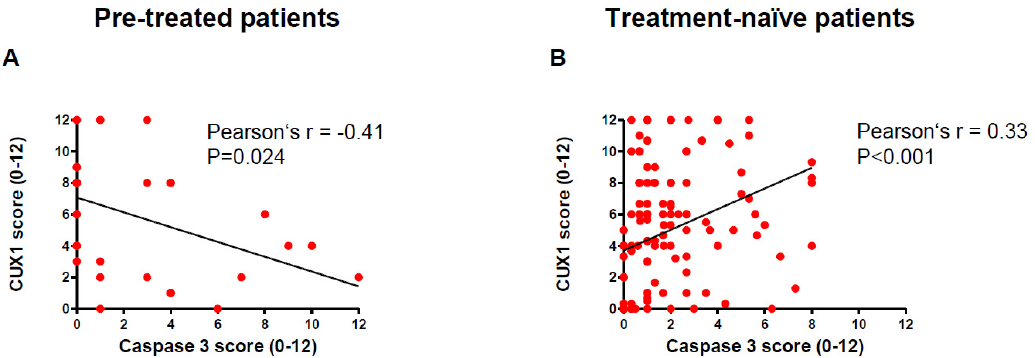
Figure 4. ( A )Pearson’s correlation test between CUX1 und caspase 3 IRS in the pre-treated group. Number of pairs = 31, 95% CI -0.66 to -0.059, r = − 0.41, p = 0.024. ( B ) Pearson’s correlation test between CUX1 und caspase 3 IRS in the treatment-naïve group. Number of pairs = 141, 95% CI 0.17 to 0.47, r = 0.33, p <